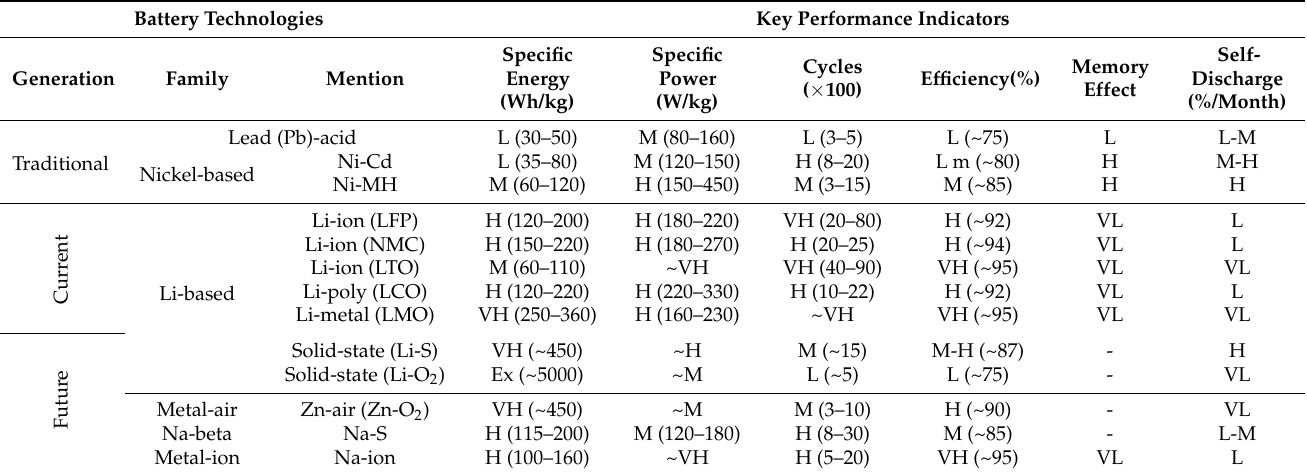
Table 1. Comparison: key performance indicators of battery technologies. Here, the data are interpreted from the literature [20,36,38,65,74].